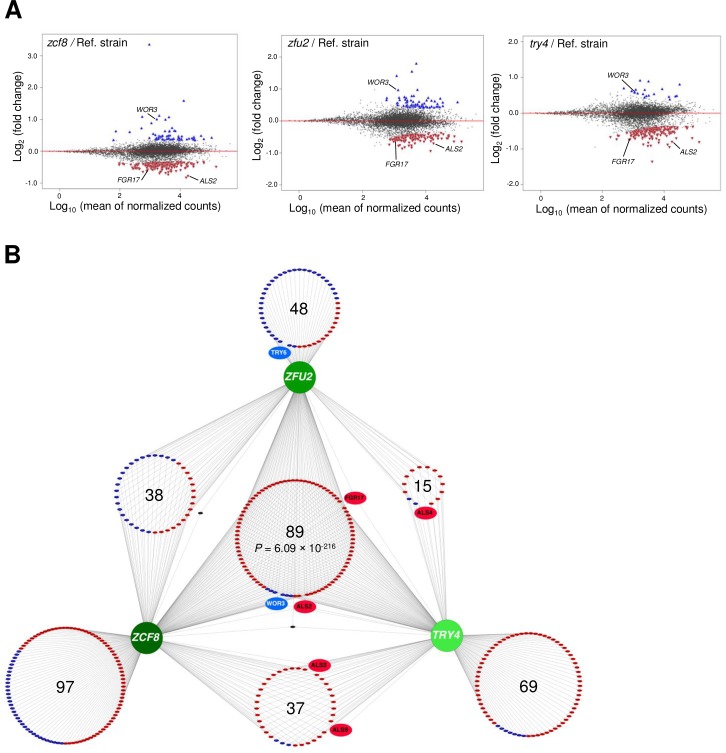
RNA-seq mapping of the transcriptional regulatory network controlled by the identified regulators ZCF8, ZFU2 and TRY4.(A) Plots show the distribution of all analyzed transcripts (∼6100 genes; each dot represents one transcript) when comparing the indicated deletion mutant to the wild-type reference strain. Plotted is the log2 fold change in expression (Y-axis) as a function of the mean of the normalized read counts (X-axis) for each transcript. Colored triangles correspond to transcripts whose expression is activated (i.e. positive regulation) (red) or repressed (i.e. negative regulation) (blue) by each regulator at Padj < 0.01. (B) Network view of the full set of genes whose expression is influenced by the identified C. albicans transcription regulators. The nodes of the network (in shades of green) are transcription regulators identified in our genetic screen. Large circles are composed of small colored ellipses. Each one of the latter represents an individual target gene. Positive (i.e. activation) and negative (i.e. repression) regulation is indicated by red and blue colors, respectively. The two black small ellipses depict the two genes that show discordant regulation (i.e. they are positively controlled by one regulator and negatively regulated by another). The shown network is completely based on RNA-seq data generated in this study.